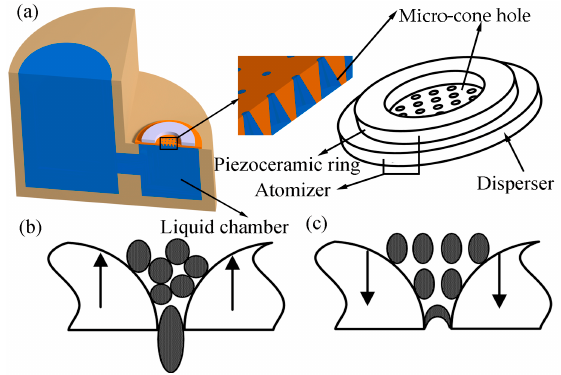
Figure 1. Illustration of the micro-cone hole atomizer structure and its principles, as provided by Lu. ( a ) Schematic of the atomizer structure; ( b ) liquid flow generated in the upward-vibrating micro-tapered aperture; ( c ) liquid flow generated in the downward-vibrating micro-cone hole.